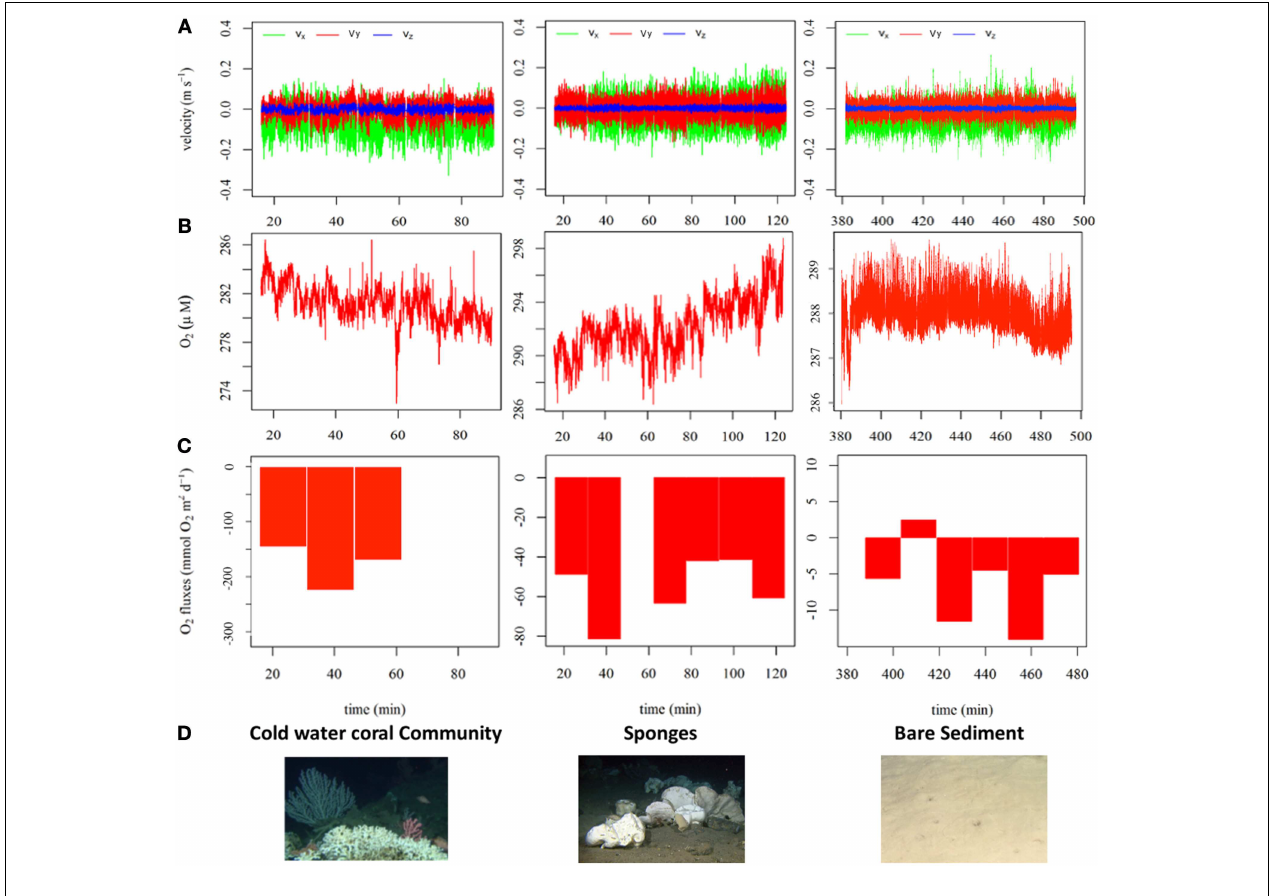
(B) Raw O 2 concentration data after a 3Hz low-pass filtering. (C) Derived O 2 flux for each burst (rectangles). (D) Images of the corresponding habitats and associated communities (Cold water coral, sponges and bare